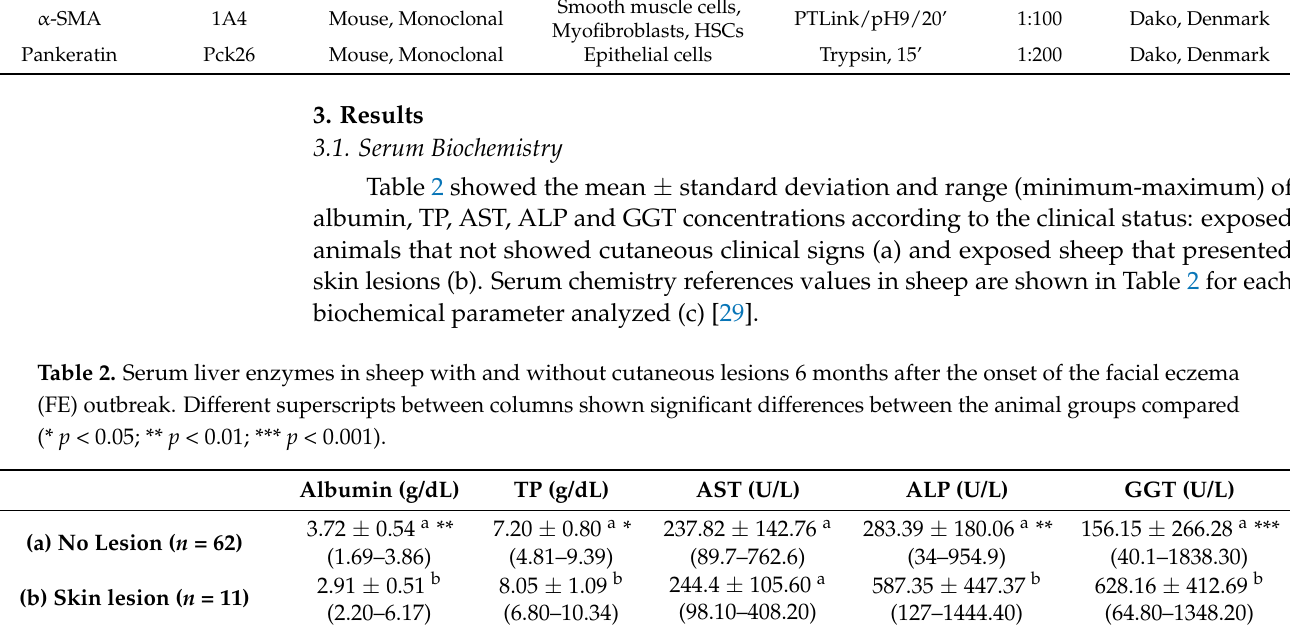
(a) No Lesion ( n = 62) (b) Skin lesion ( n = 11) (c) Reference values